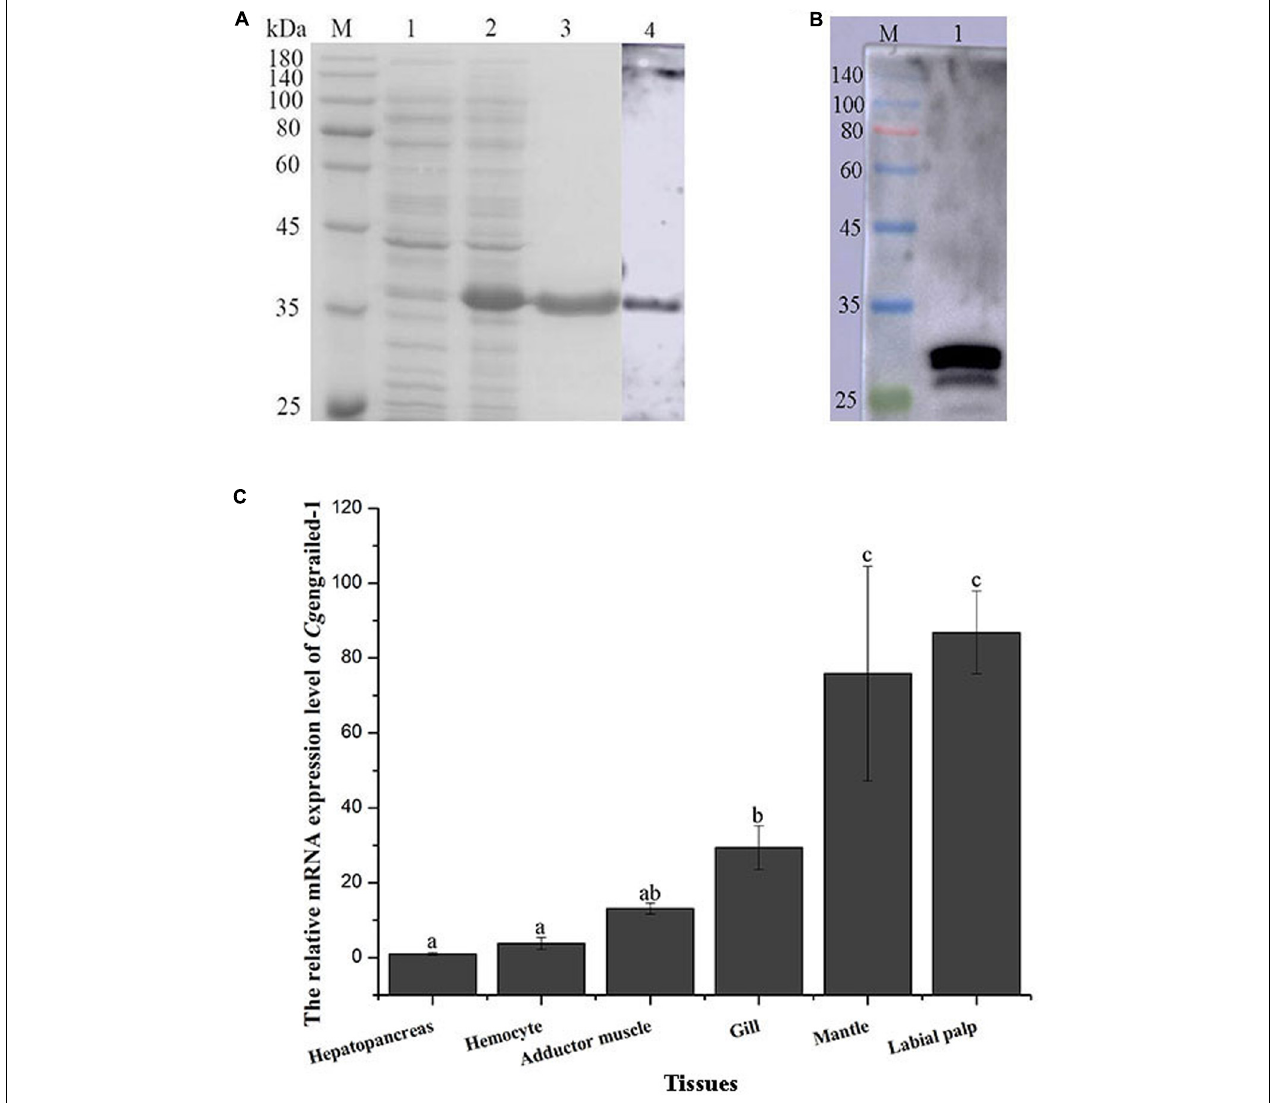
FIGURE 2 | (A) SDS-PAGE and western blot analysis of r Cg engrailed-1. Lane M: protein molecular standard; Lane 1: Proteins form E. coli without IPTG induction; Lane 2: positive transformant induced by IPTG; Lane 3: purified r Cg engrailed-1; Lane 4: western blot analysis of the polyclonal antibody against r Cg engrailed-1. (B) Western blot analysis of Cg engrailed-1 from mantle. Lane M: protein molecular standard; Lane 1: natural protein isolated from mantle. (C) Cg engrailed-1 mRNA expression level in different tissues. Each value was shown as mean ± SD ( N = 3), and statistical significance ( p < 0.05) was marked by different letters